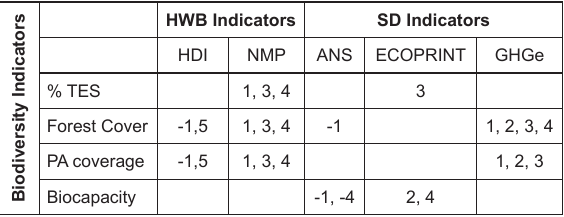
Table 2. Correlation between biodiversity and HWB and SD indicators across the continents. Only significant correlations (p < 0.05) are included.